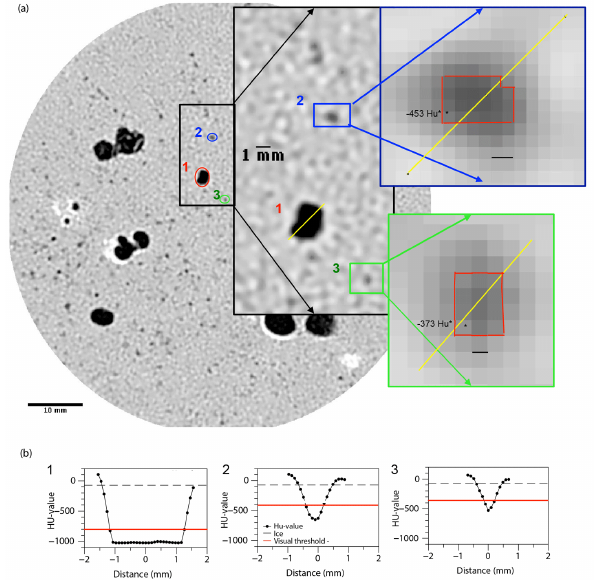
Figure 3. (a) Raw transversal slice where grey pixels represent ice and black pixels represent air; darker grey pixels are pixels con- taining air and white pixels contain brine. We highlighted three air inclusions: an air inclusion (1) larger than the spatial resolution and two inclusions (2 and 3) which are smaller than the spatial resolu- tion, their HU value never reached the HU value of air; instead they appeared as mixed pixels and their HU value reflects the propor- tion of air, ice and brine in the pixel. The red line shows the visual boundary of the bubble where the lowest HU value observed for pixel ( ∗ ) is the visual threshold. (b) The distribution of HU value along the transects (yellow lines in a